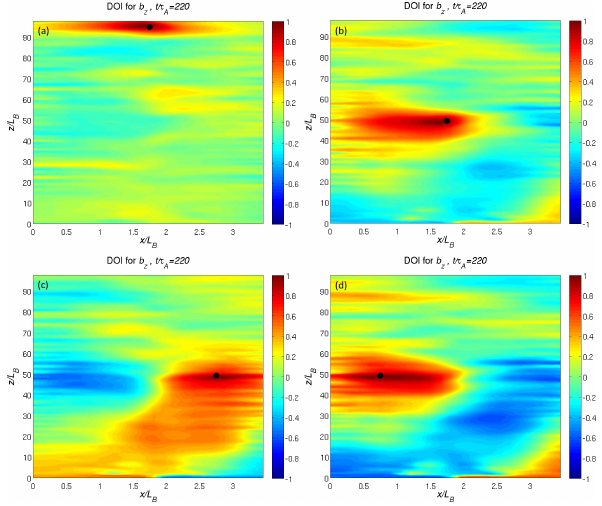
Fig. 8. Domain of influence for the z component of the magnetic field b z for the assimilation of a magnetic field observation made at different locations at the same time step, t/τ A = 220. The black circle indicates the data observation location. (a) refers to location 4 (L1, 1 AU), (b) to location 3, (c) to location 5 and (d) to location 6. The spatial dimensions are normalised to L B , the length scale of variation of the magnetic field; time is normalised to the Alfvén time τ A